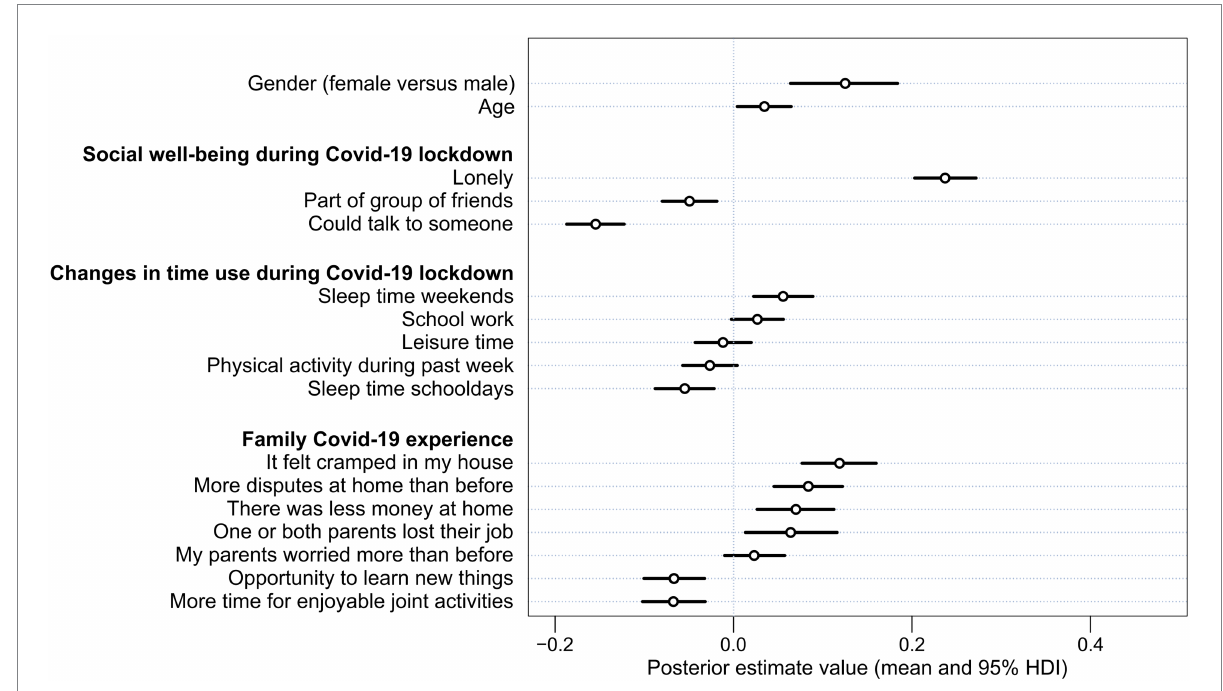
FIGURE 1 Posterior estimate mean values and uncertainty (95% HDI intervals) of stressors in adolescents during the spring 2020 lockdown (Model 3). Standardized variables ( z -scores) were